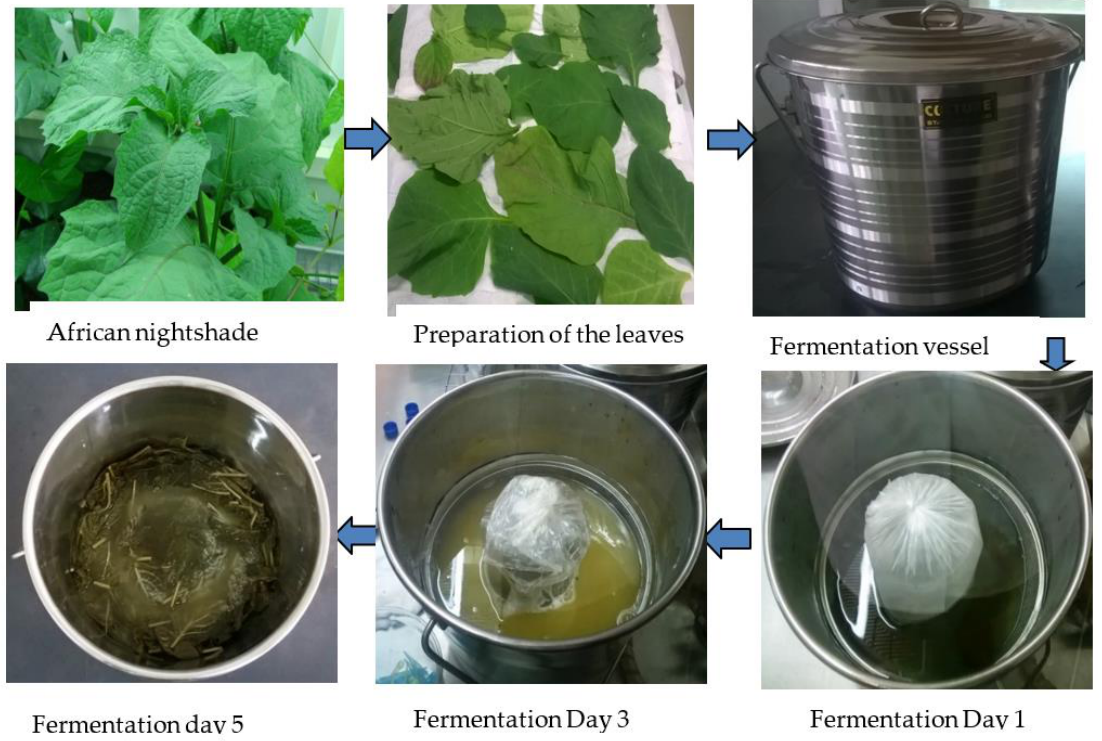
Figure 10. Fermentation of African indigenous leafy vegetables .